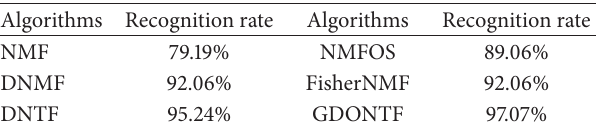
Table 1: Comparison of the best recognition rates for all tested algorithms.